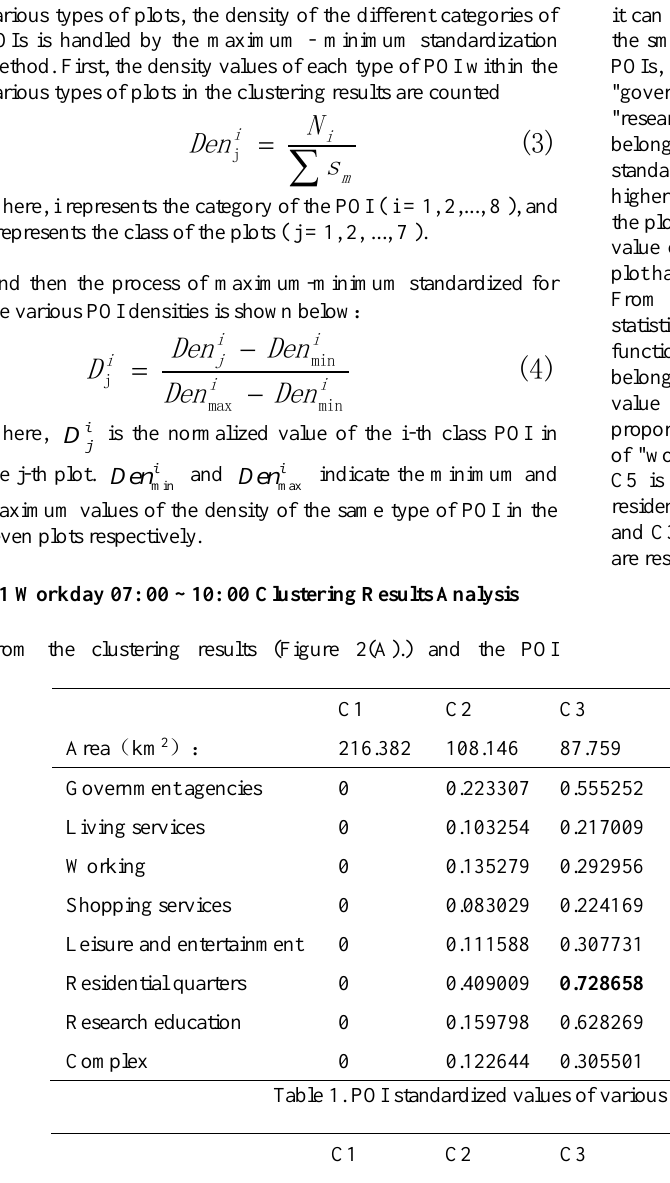
statistical results (Table 1.) of the O-points from 07:00 to 10:00, it can be seen that the block of C7 with the highest density is the smallest area. As the relatively high standard values of all POIs, C7 is a mixed area. The POI standard values of "government agency", "working", "residential quarter" and